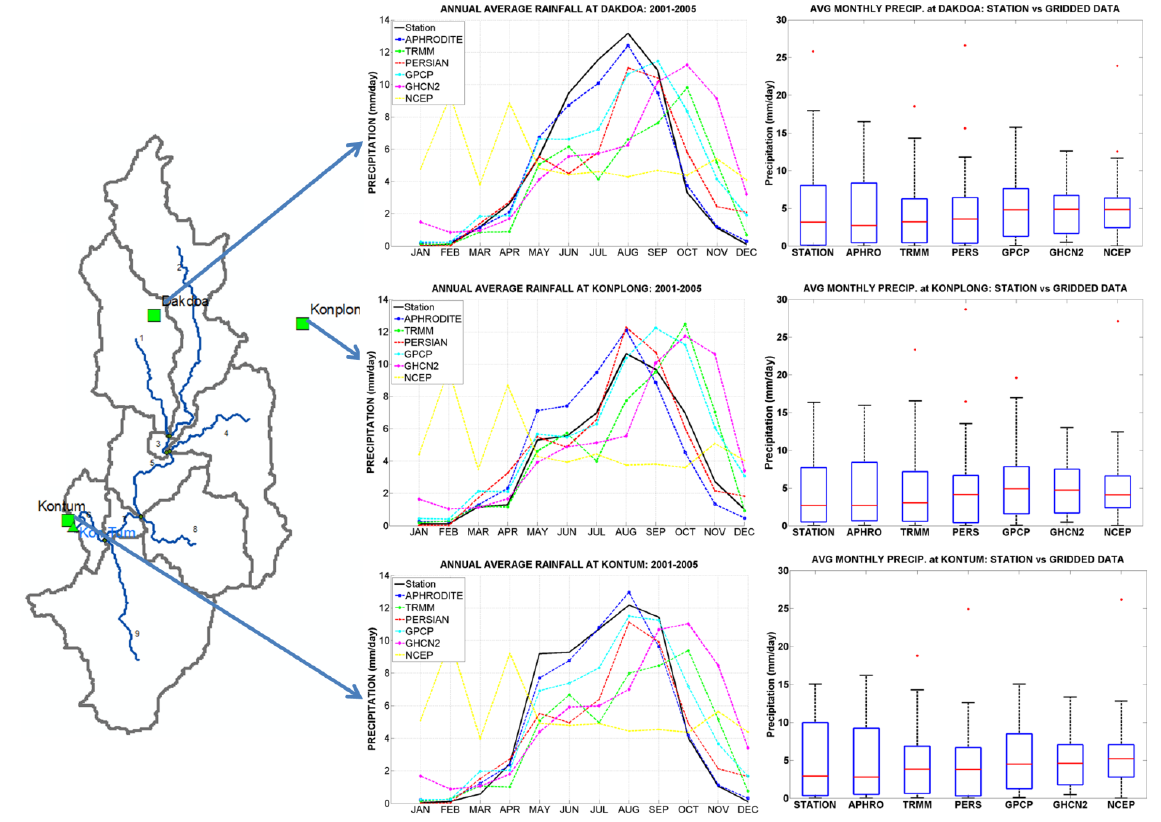
Fig. 4. Annual cycle and box plots for observed station and gridded observation precipitation at three rainfall stations in study region, daily data from 2001–2005.